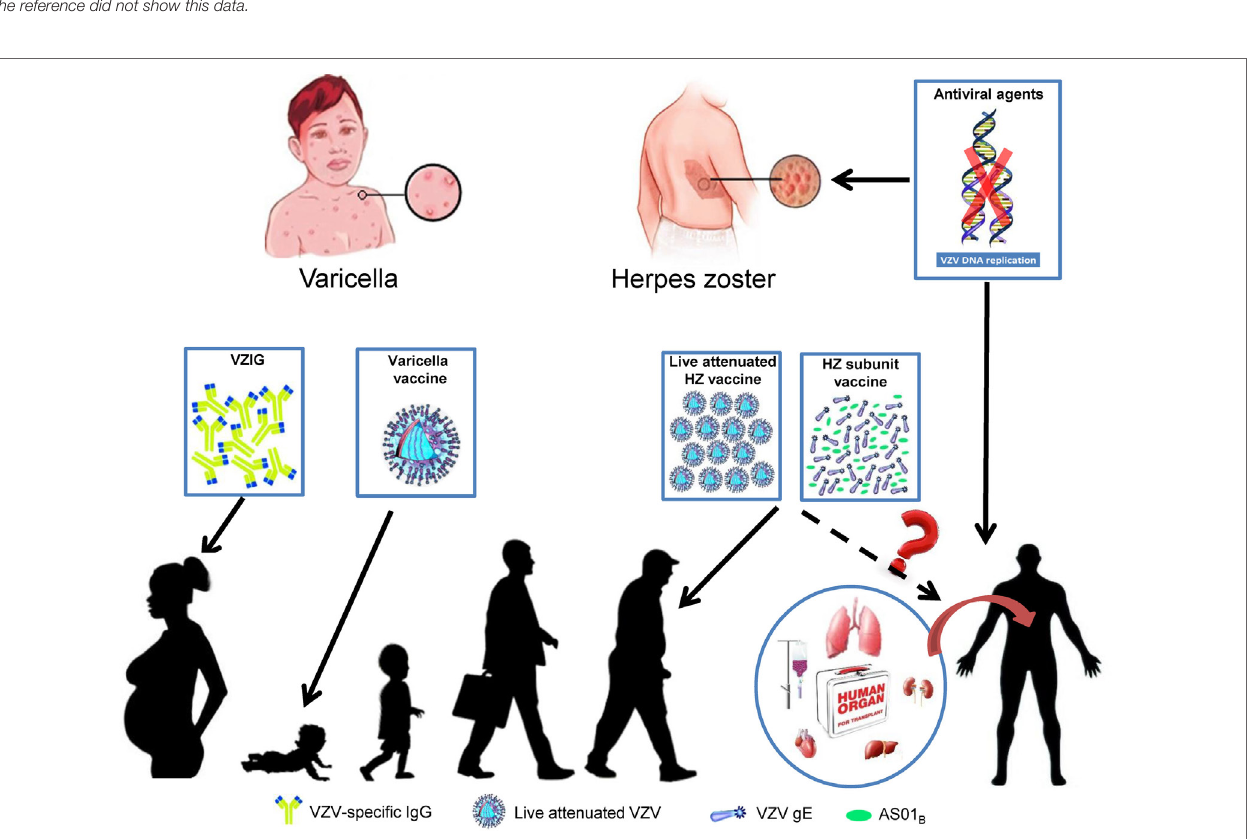
FigURe 1 | Treatments and prevention of varicella and herpes zoster